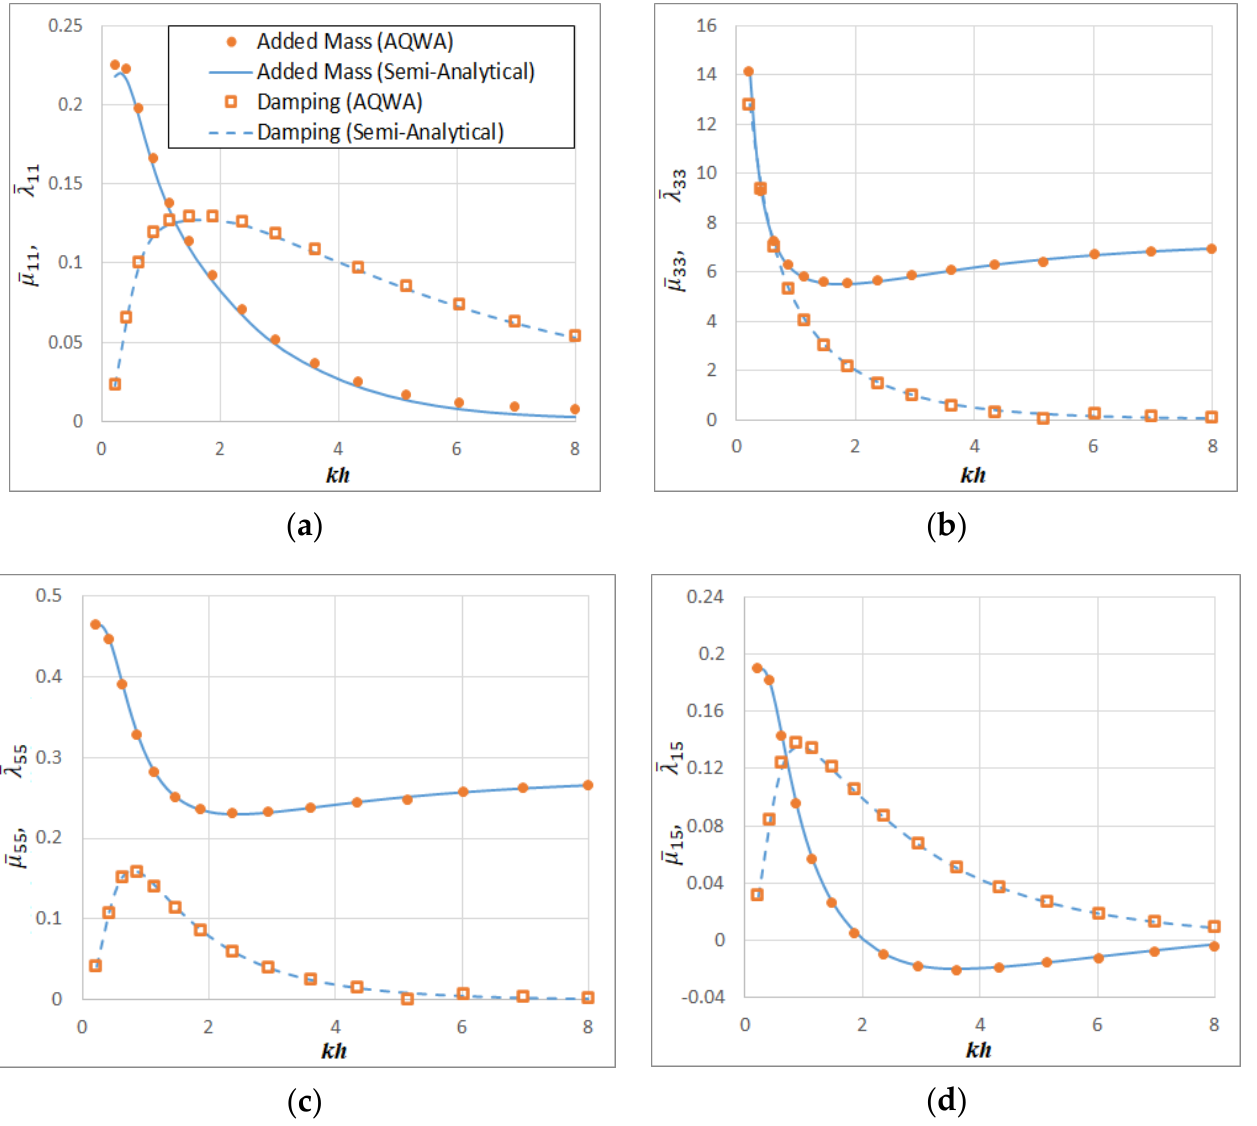
Figure 3. Comparison of added mass and radiation damping obtained from AQWA and semi-analytical method: ( a ) for µ and λ 11 ; ( b ) for µ 𝜆̅ . (cid:2869)(cid:2873)